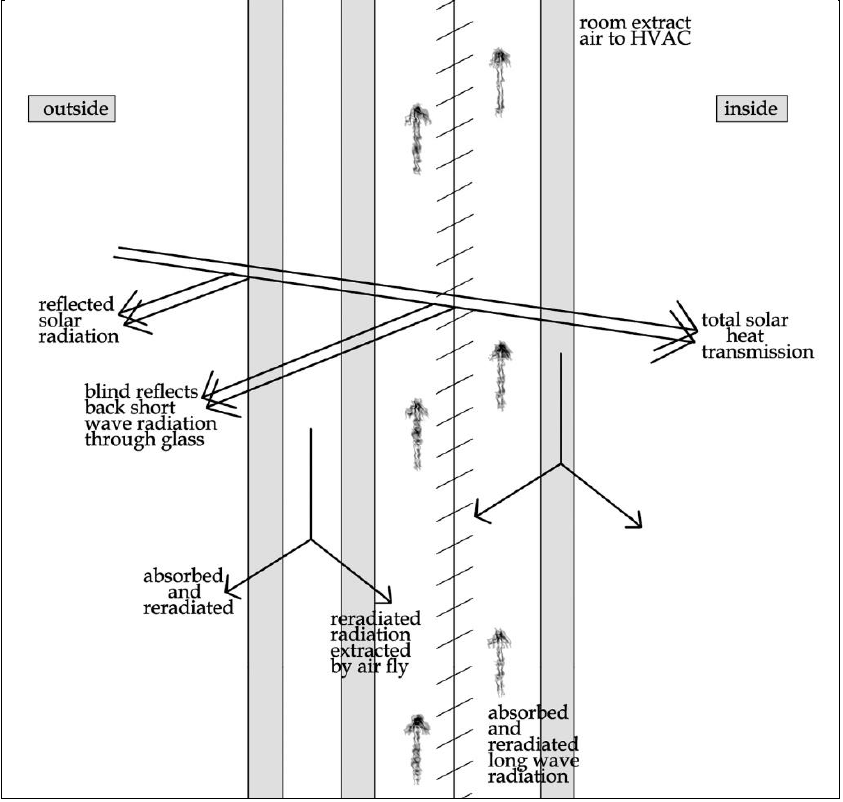
Figure 11. The active facade system (figure by authors).